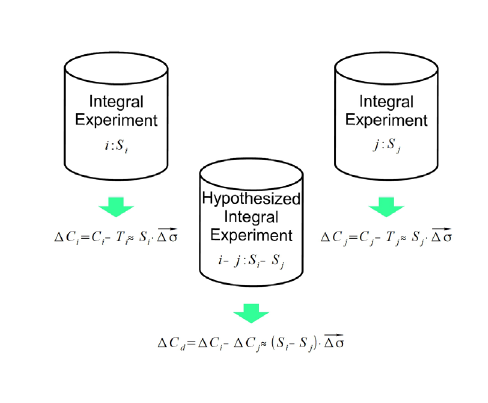
Figure 3. Explanation of O dissimilarity